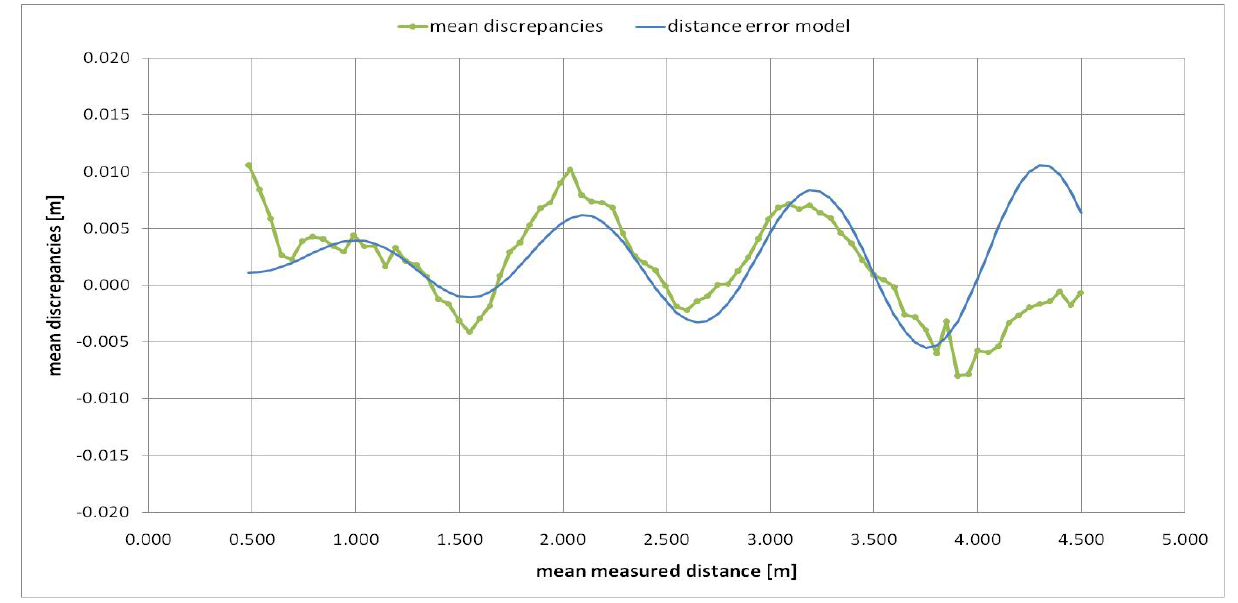
Figure 5. Variation of the mean values of the discrepancies ( g ) of all the considered pixels according to the mean measured distance ( s ) and distance error model.